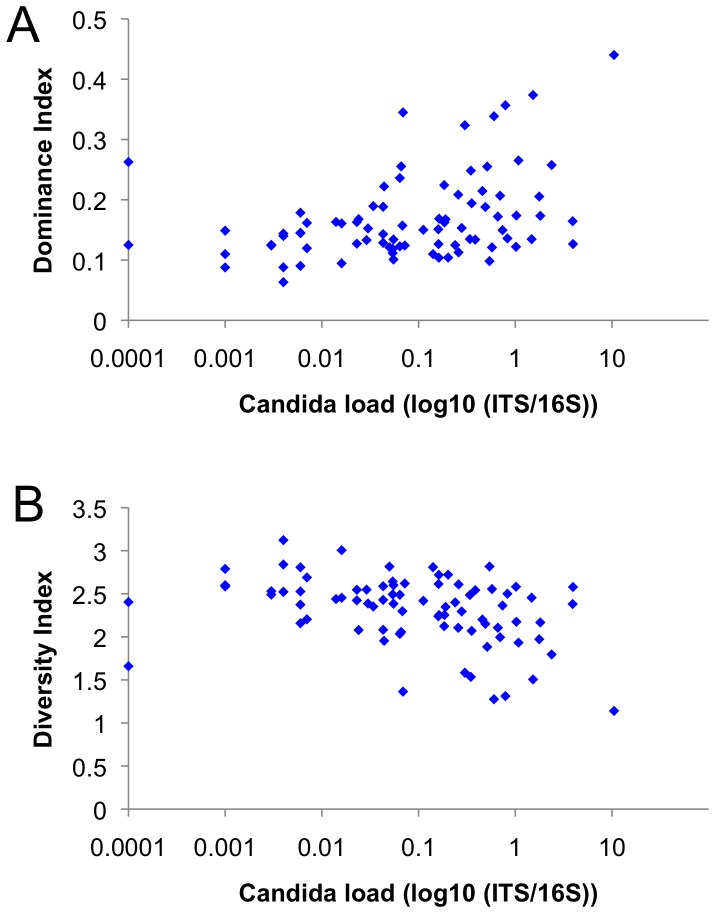
Diversity statistics of salivary microbiomes by Candida load.Diversity statistics of salivary microbiomes as: A) Dominance Index and B) Shannon Diversity Index by log10 Candida ITS/16S gene. Candida load correlated positively with the Dominance Index (p<0.001; Spearman’s rho 0.388) and negatively with the Shannon Diversity Index (p<0.001; Spearman’s rho −0.403).